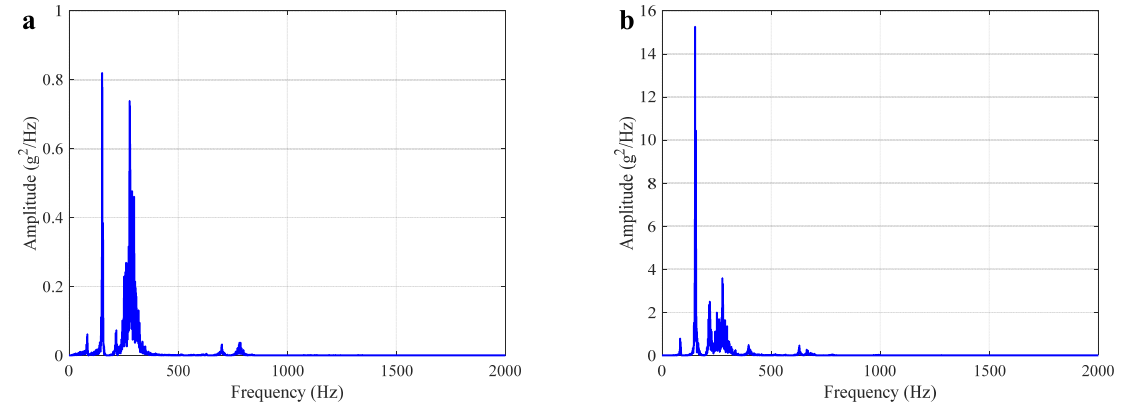
Figure 14. Random vibration load spectrum of experiment rack simulator.